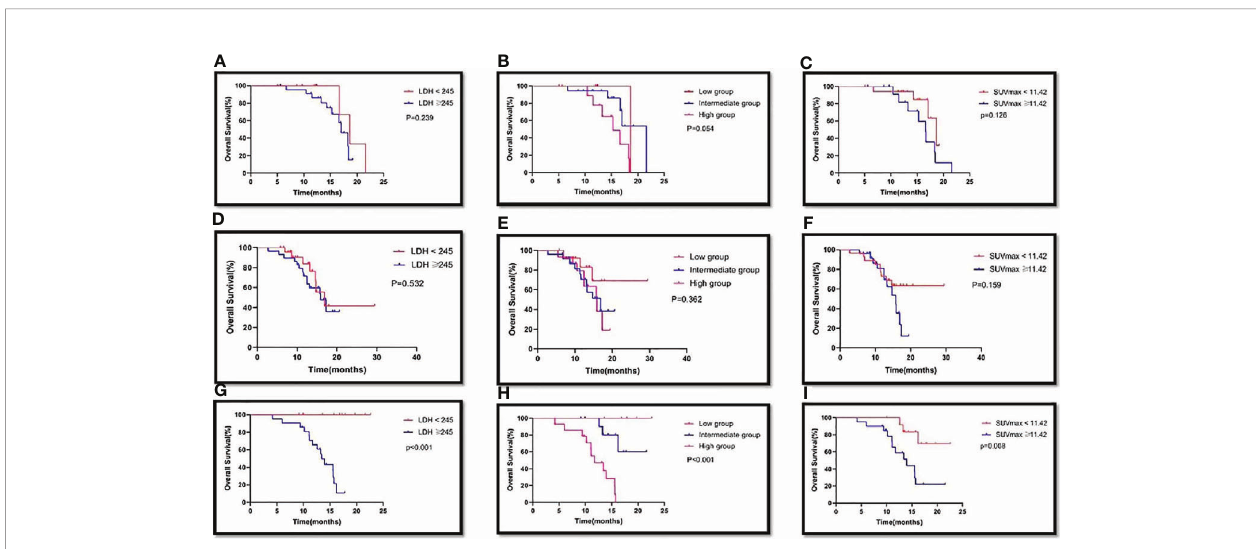
FIGURE 5 | Survival curves of LDH(<245 VS ≥ 245), combination group(Low group, LDH<245 and SUVmax<11.42; intermediate group, LDH<245 or SUVmax<11.42; high group, SUVmax ≥ 11.42 and LDH ≥ 245) and SUVmax(<11.42 vs ≥ 11.42) of primary tumor in Squamous NSCLC (A,B,C) , Non-Squamous NSCLC (D,E,F) and SCLC (G,H,I) with advanced lung cancer,